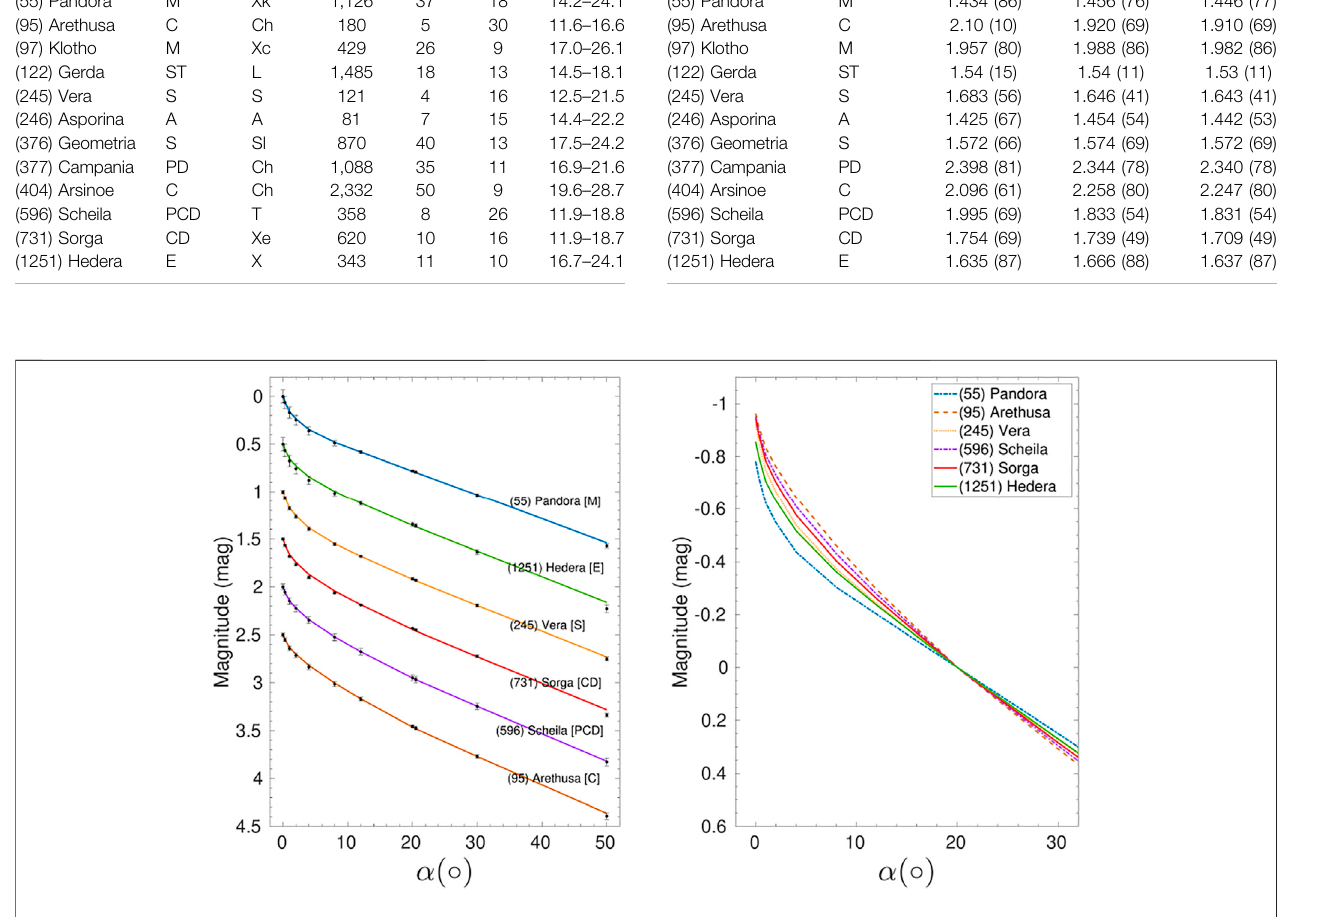
FIGURE7 | Photometric phase functions with H , G 1 , G 2 - fi ts forasteroids(55) Pandora (95) Arethusa (245) Vera(596) Scheila(731) Sorga, and (1251) Hedera. For illustration, the phase functions are presented on a relative magnitude scale with 0.5-mag offsets (left) and normalized at 20 °